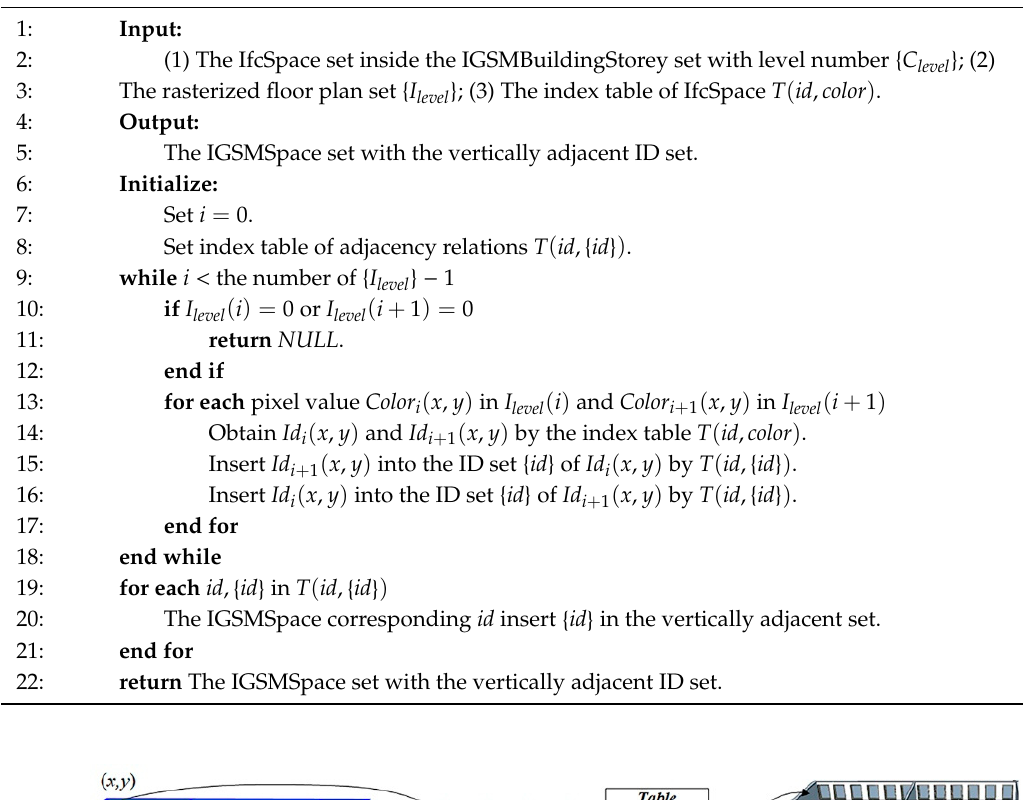
Figure 10. Diagram of the mapping and rasterization (sample data from Table 2. Office Building). ( a )